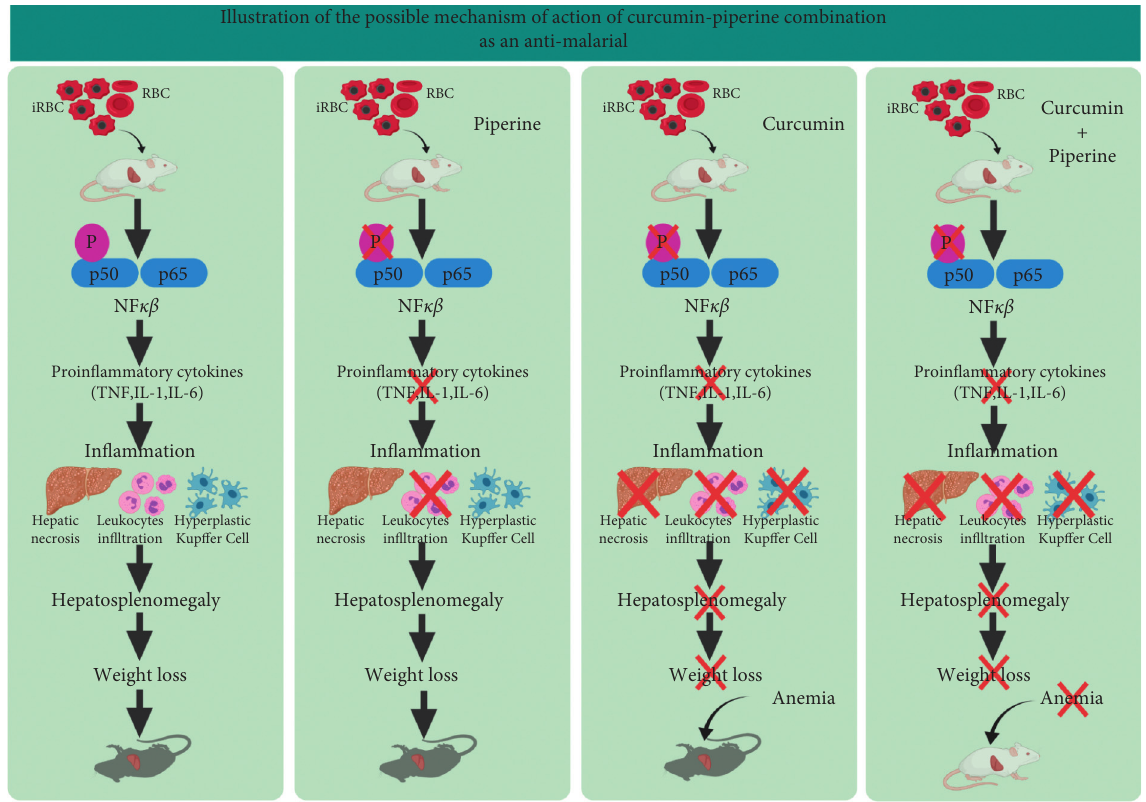
Figure 4: An illustration to explain the mechanism of action of curcumin-piperine combination as an antimalarial in animal models. When Swiss mice are infected with P. berghei ANKA strain, they show malaria symptoms and die between 8 and 12 days. Piperine alone inhibits phosphorylation of NF kappa B prevents leukocyte infiltration, but hepatic necrosis and hyperplasia of Kupffer cells remain visible. The animals eventually die due to parasite build up, causing hepatosplenomegaly and weight loss. Curcumin alone is also known to inhibit the phosphorylation of NF kappa B preventing leukocyte infiltration, hepatic necrosis, and hyperplasia of Kupffer cells. Thus, hep- atosplenomegaly and weight loss are not seen. However, the animal eventually died by almost 20 days due to parasite build up and anemia. However, if the animals are given piperine and curcumin combination, the parasites are cleared and the animals are completely protected against mortality. Thus, while curcumin counteracts the inflammatory response, piperine potentiates the effects of curcumin, making this combination as a potential therapy for preventing